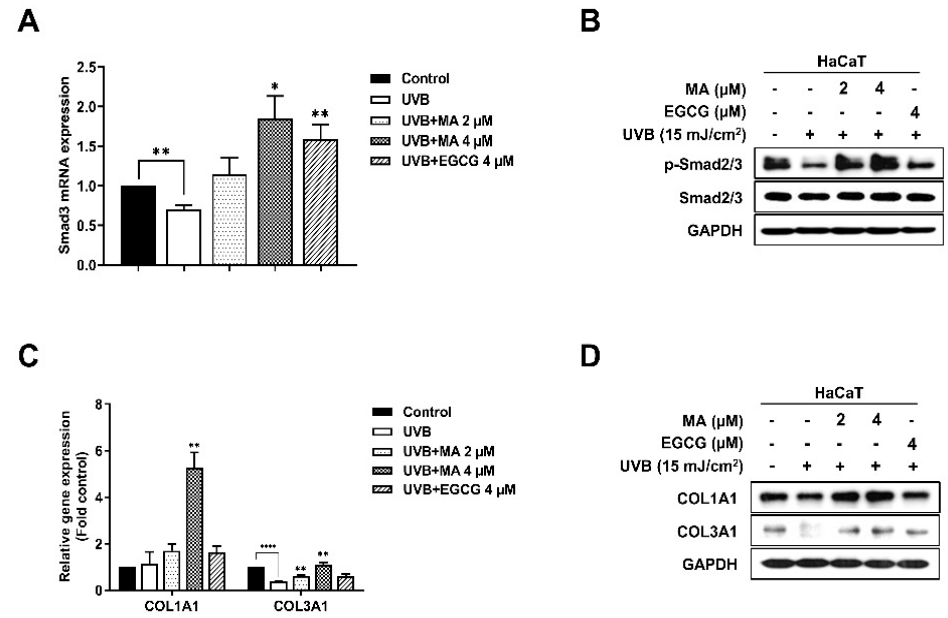
Figure 5. Effect of malonic acid (MA) on the expression of transforming growth factor (TGF)- β /Smad signaling components, collagen synthesis factor, and type I procollagen mRNA in ultraviolet (UV) B-irradiated HaCaT cells. (A-D) HaCaT cells have been treated with MA for 4 h and then exposed to UVB irradiation (15 mJ/cm 2 ). After an overnight incubation following UV exposure, ( A ) Smad3 mRNA expression is evaluated by real-time polymerase chain reaction (PCR), and ( B ) the protein level of phosphorylated Smad2/3 is measured by western blot analysis. ( C ) col1a1 and col3a1 mRNA expression are evaluated by real-time PCR, and ( D ) the protein levels of Col1a1 and Col3a1 are measured using western blot analysis. Glyceraldehyde 3-phosphate dehydrogenase (GAPDH) is used as an internal control for western blot analysis. Epigallocatechin-3-gallate (EGCG) is used as a positive control. +, - means UVB irradiation or non-irradiation and treatment or non-treatment of MA and EGCG. The data were analyzed in triplicate and displayed as the mean ± the standard error of the mean (SEM). (*) p < 0.05, (**) p < 0.01, (***) p < 0.001, and (****) p < 0.0001.